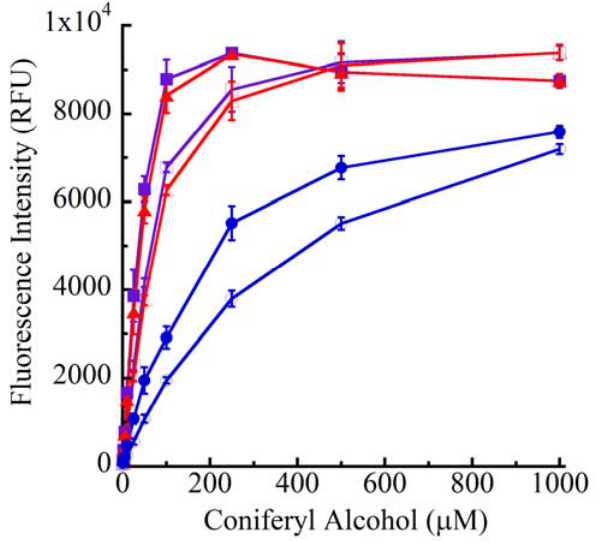
Figure 10A. Sensitivity of CA. Increasing (1.0 to 1000  M) concentrations of unmodified CA diluted in 100 mM NaOH were dispensed into a 384-well white plate as 25 or 50  L solutions. Fluorescence from the samples was measured at 416 nm using the excitation wavelengths of 290 (purple tracings; open squares, 25  L; closed squares, 50  L), 310 (red tracings; open triangles, 25  L; closed triangles, 50  L) and 340 nm (blue tracings; open circles, 25  L; closed circles, 50 